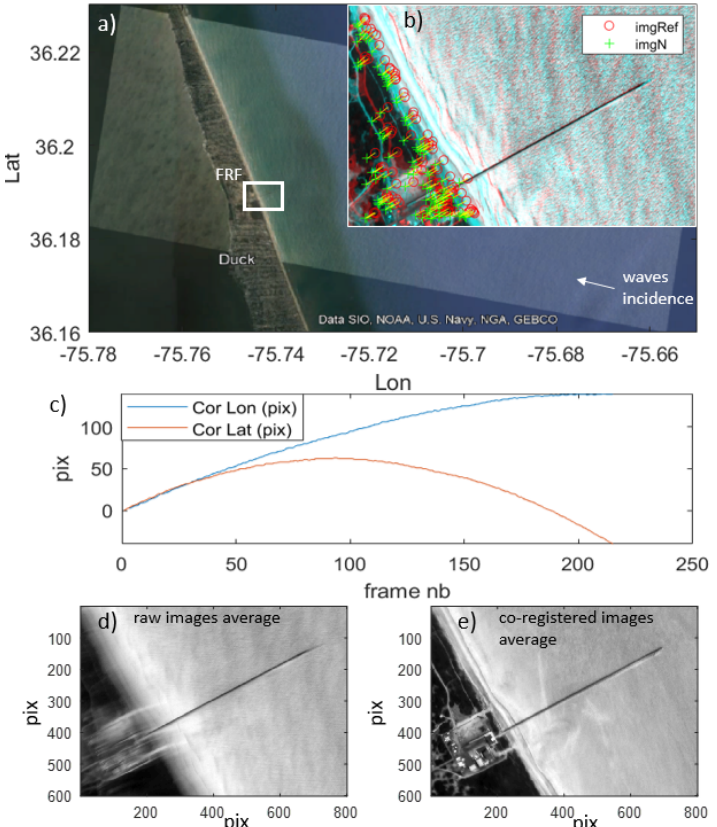
Figure 1. ( a ) Jilin video acquisition viewfield at Duck (USA) on 7 June 2020 with ( b ) an inset illustrating the co-registration between the first and last frame of the sequence using a spatial correlator. Red and green symbols stand for the captured displacement of homologous points. ( c ) Co- registration of images in the sequence (with reference the first image) showing the drift in Longitude and Latitude over time. ( d , e ) are the raw and co-registered image averages. The Jilin video sequence was obtained from a CG Satellite in 2020 (Distribution CG), acquired within the framework of a CNES